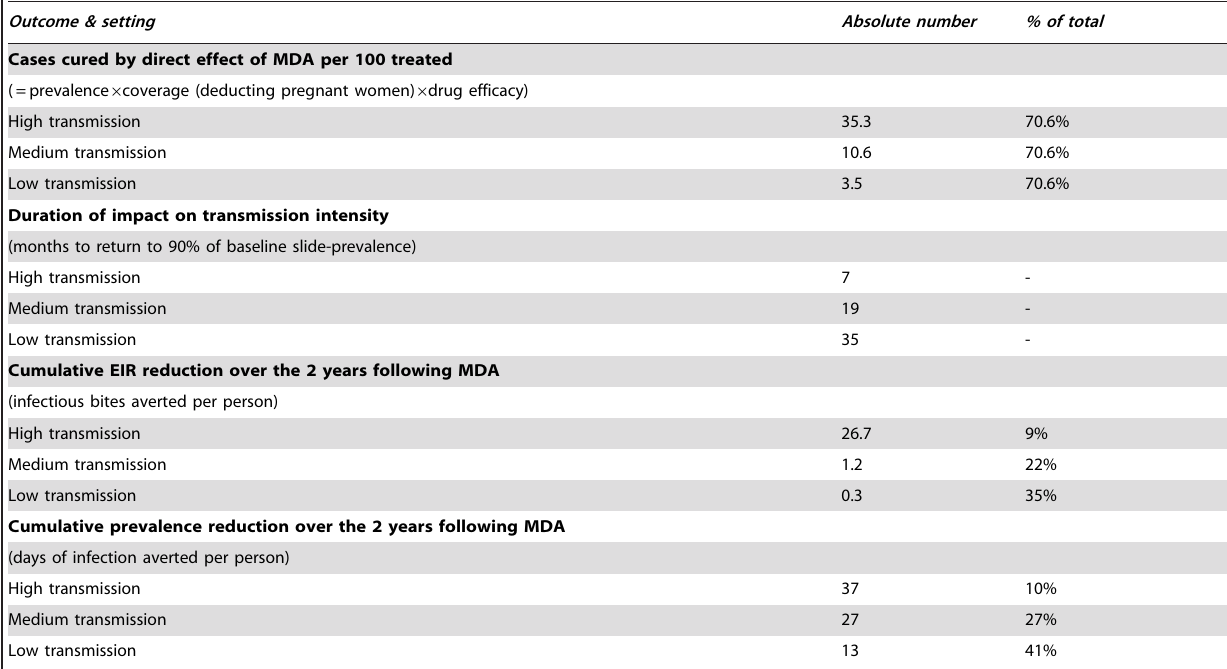
Table 2. Short-term and long-term impact of a single round of MDA.